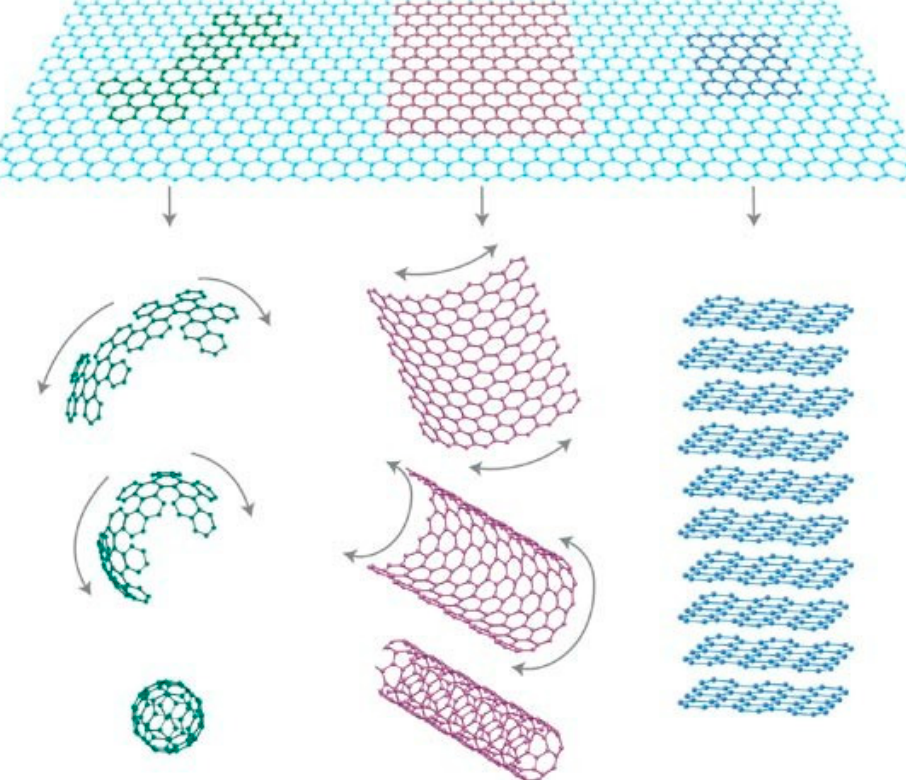
Figure 1. Graphene and its derivatives: 0D fullerene, 1D carbon nanotubes, and 3D graphite. Reprinted with permission from [37]. Copyright@ Springer–Nature.